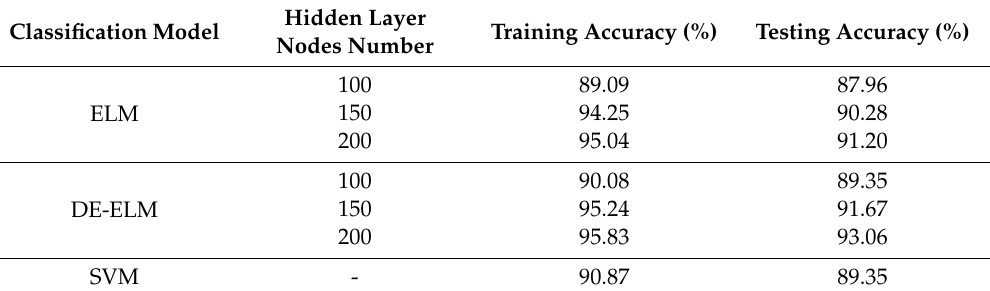
Table 2. Classification accuracy of ELM, DE-ELM and support vector machine